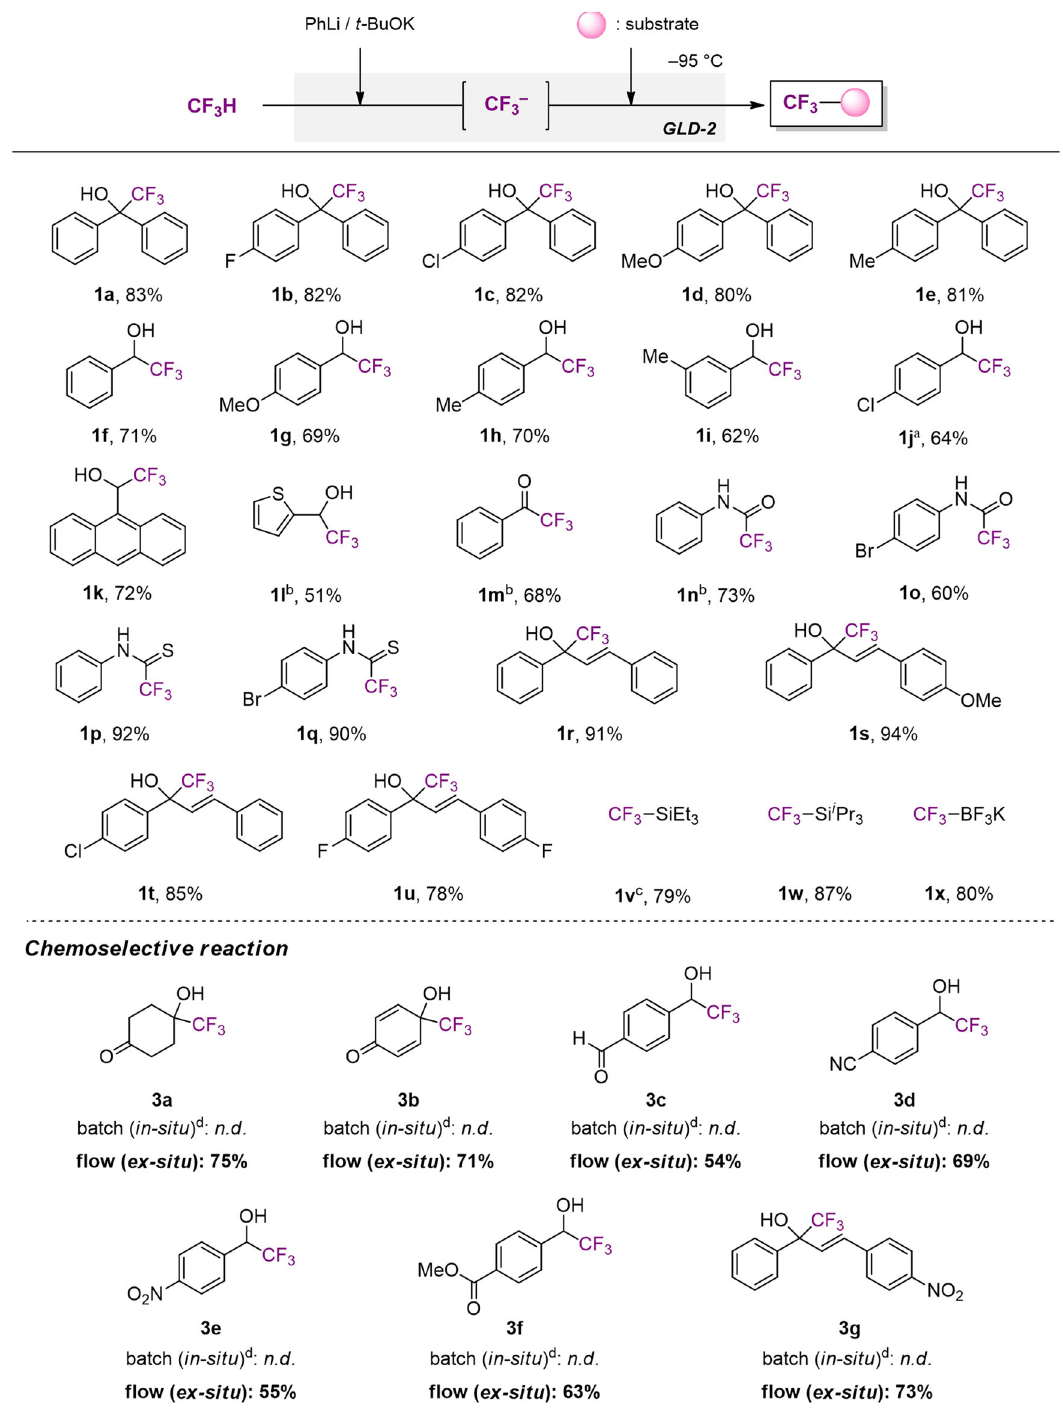
Isolated yield. a The resulting CF 3 − solution was reacted with an electrophile at − solution was reacted with an electrophile at − 78°C. c TESCl (2 – 50°C. b The CF 3